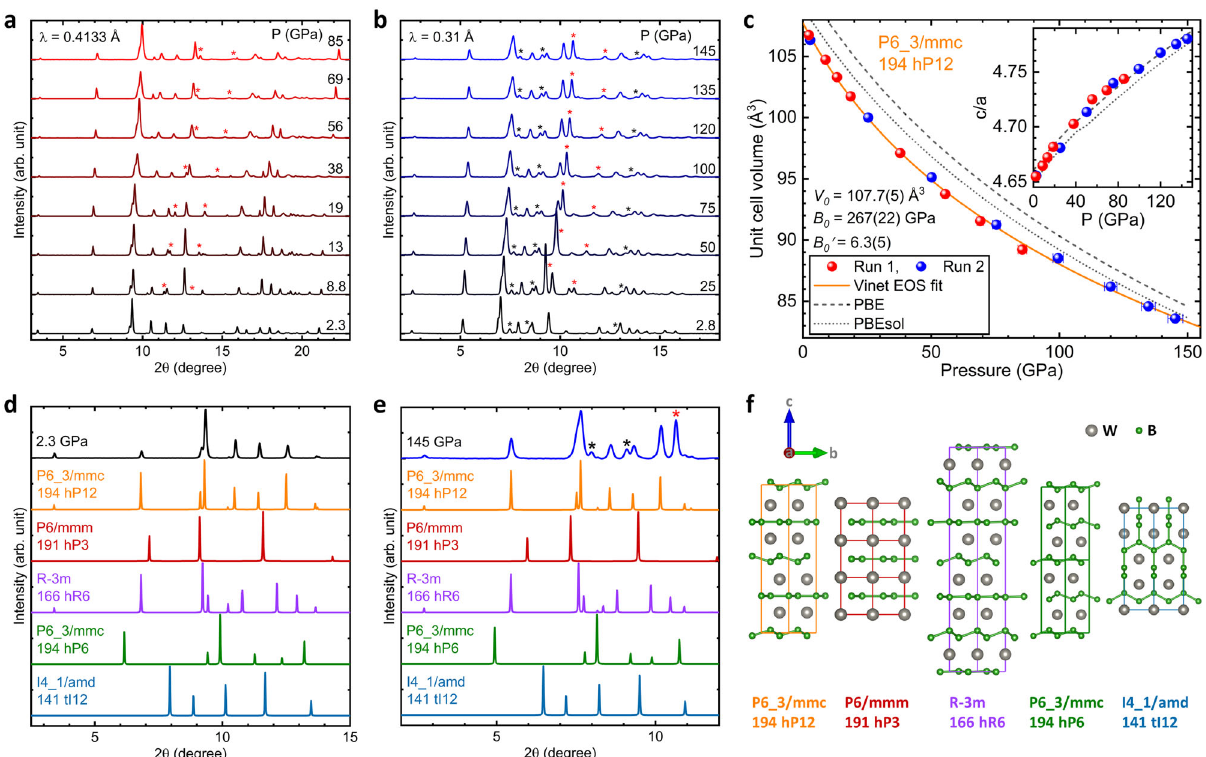
Fig. 2 | High-pressure XRD patterns, PV-isotherm, and crystal structure com- parison. a , b High-pressure XRD patterns of WB 2 obtained from Runs 1 and 2, respectively, at room temperature using Ne as the quasi-hydrostatic pressure medium. No structural transition was observed throughout the pressure range studied.ThestarsymbolsdenotetheBraggpeaksoftheRegasket(blackcolor)and the Ne pressure-transmitting medium (red color), respectively. c The resulting pressure – volume (P – V) curve fi tted with the Vinet equation of state (EOS) 46 . The